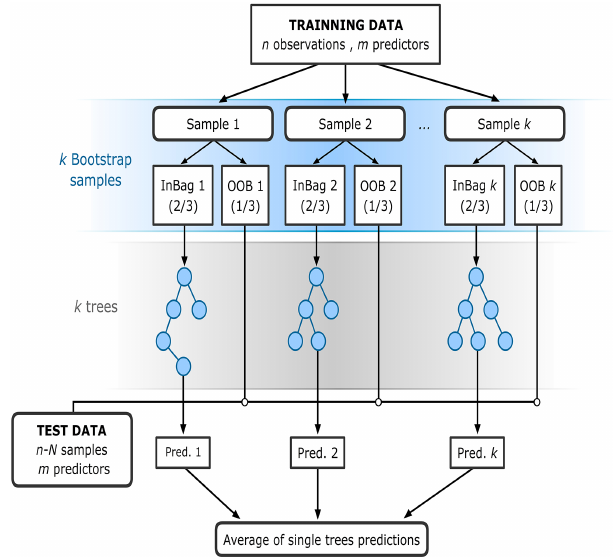
Figure 3. The flowchart of random forest (RF) for regression (adapted from Rodriguez-Galiano et al., 2015b). The RF method receives a subset of input vectors ( n ), made up of one phenology z score value and the values of the corresponding weather predictors for a given location and year. RF builds a number K of regression trees making them grow from different training data subsets, resam- pling randomly the original data set with replacement. Hence, most data will be used multiple times in different models. On the other hand, when the RF makes a tree grow, it uses the best predictor within a subset of predictors ( m ) which has been selected randomly from the overall set of input predictors. These special characteris- tics of RF confer a greater prediction stability and accuracy and, at the same time, avoid the correlation of the different regression tress (RTs), increasing the diversity of patterns that can be learnt from data. The multiple predictions of all K RTs for a given vector used as training are then averaged to obtain a unique estimation of the phenology z score